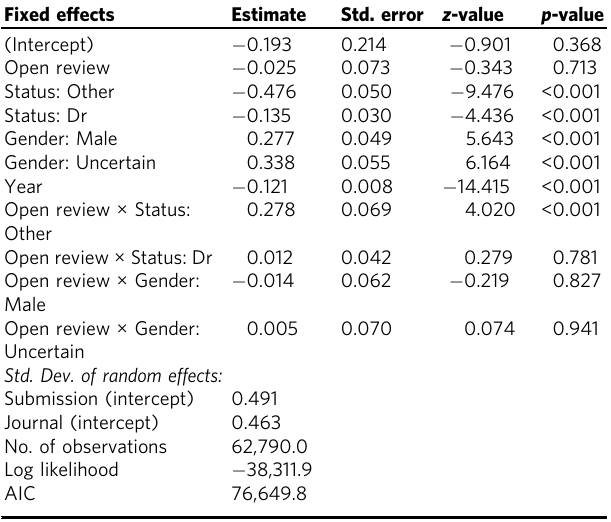
Table 1 Mixed-effects logistic model on the acceptance of editors ’ invitation by referees